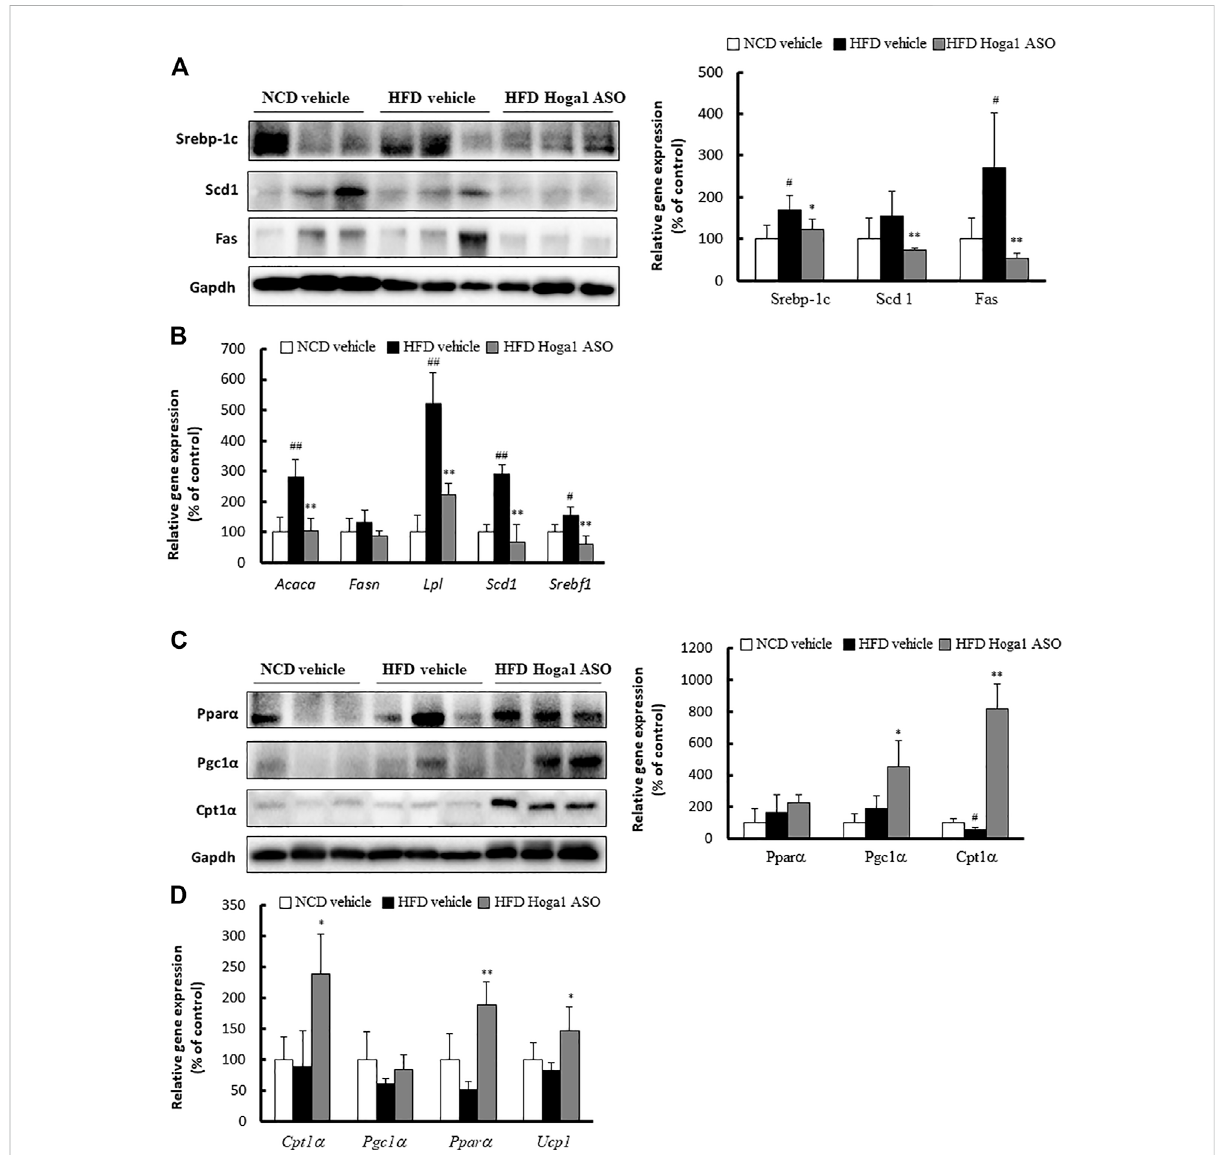
FIGURE 9 Lipogenic and lipolytic gene expression in mouse eWAT. The levels of proteins (A) and mRNAs (B) of lipogenic genes were compared in eWAT from NCD and HFD mice treated with scrambled control ASO or Hoga1 ASO. The levels of proteins (C) and mRNAs (D) of lipolytic genes were comparedineWATfromNCDandHFDmicetreatedwithscrambledcontrolASOor Hoga1 ASO.Notes:N=5pergroup.Resultsareexpressedasthe mean ± SD of three independent experiments ( # p < 0.05 and ## p < 0.01 indicate signi fi cant differences between the NCD vehicle and HFD vehicle; * p < 0.05 and ** p < 0.01 indicate signi fi cant differences between the HFD vehicle and HFD Hoga1